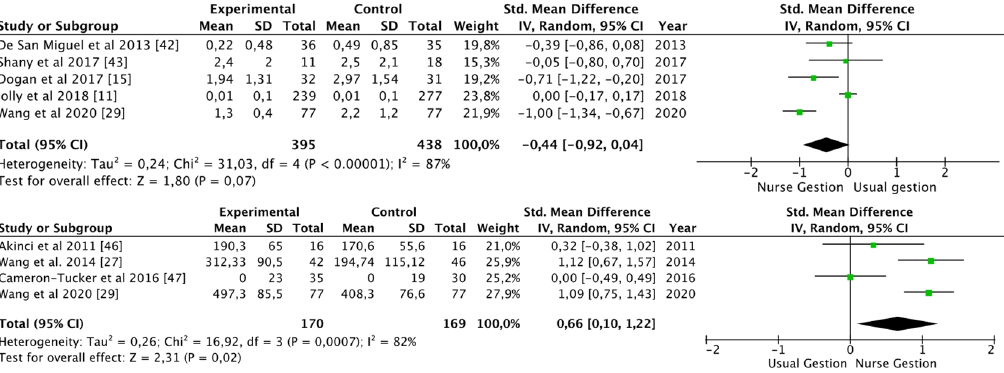
Figure 2. Number of hospital admissions and distance walked (6 MWT) [11,15,27,29,42,43,46,47].